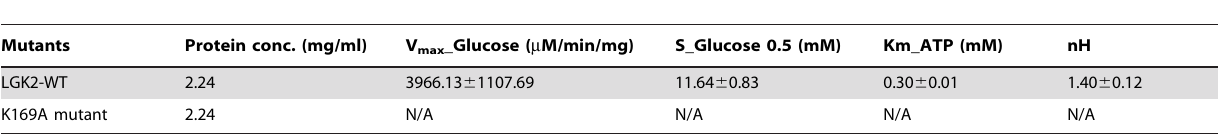
Table 1. Kinetic analysis of GK and GK K169A .